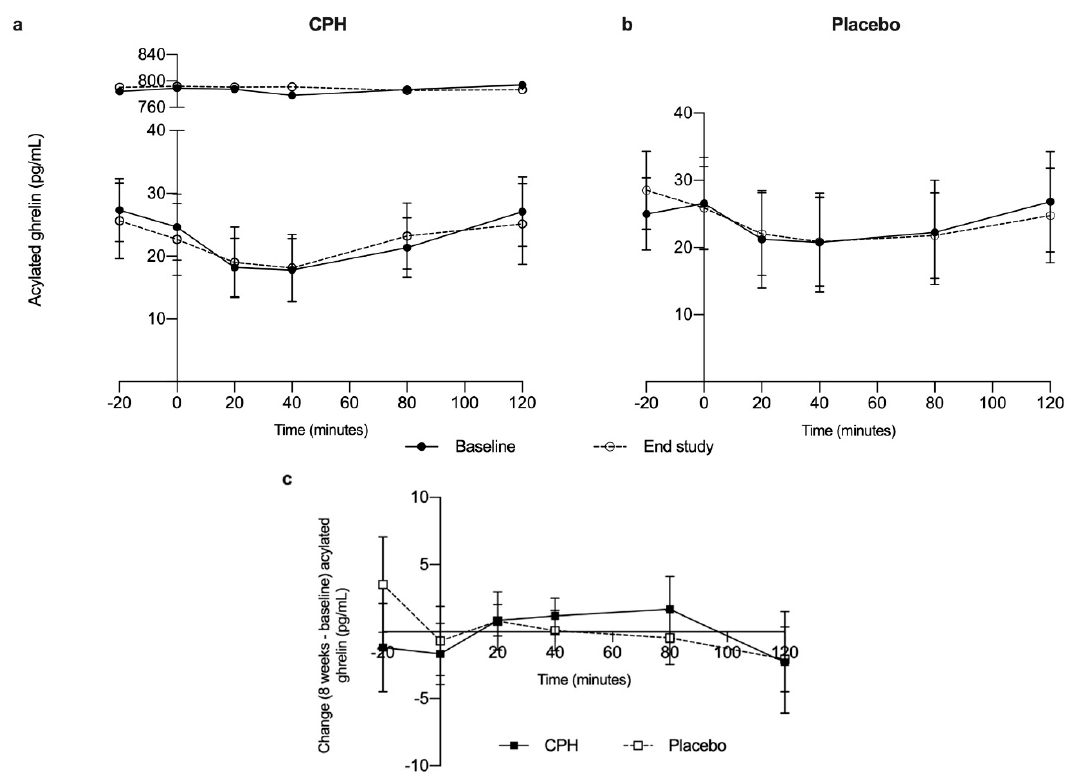
Figure 3. Fasting and postprandial acylated levels of ghrelin after a standardized breakfast meal at baseline (solid line) and end of study (dotted line) in participants that received supplementation with cod protein hydrolysate (CPH) ( n = 15) ( a ) or placebo ( n = 15) ( b ) for 8 weeks. In the CPH group, one individual had much higher levels of acylated ghrelin compared to the rest of the group and is shown as a separate segment on the graph. Graph ( c ) presents the change (calculated as 8 weeks—baseline) in acylated ghrelin during the intervention in the CPH group (solid line) compared to the placebo group (dotted line).